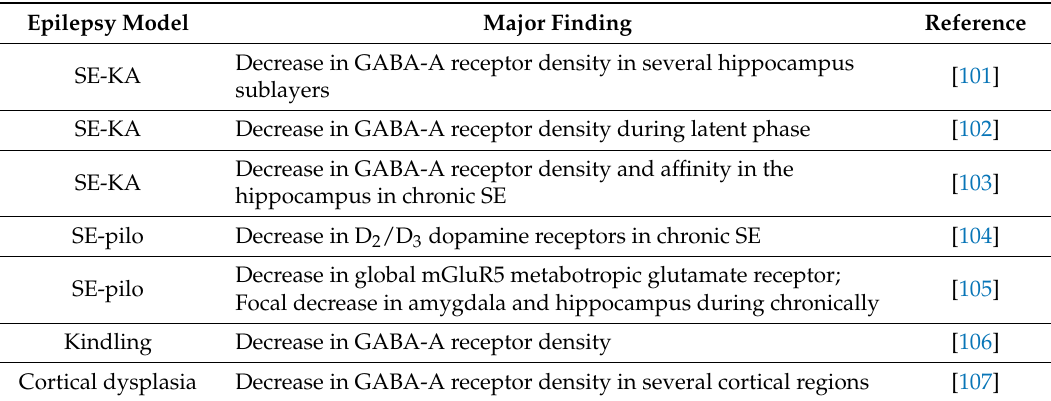
Table 9. List of PET molecular imaging studies of neurotransmitter receptors and potential biomarkers for epilepsy. Epilepsy Model Major Finding